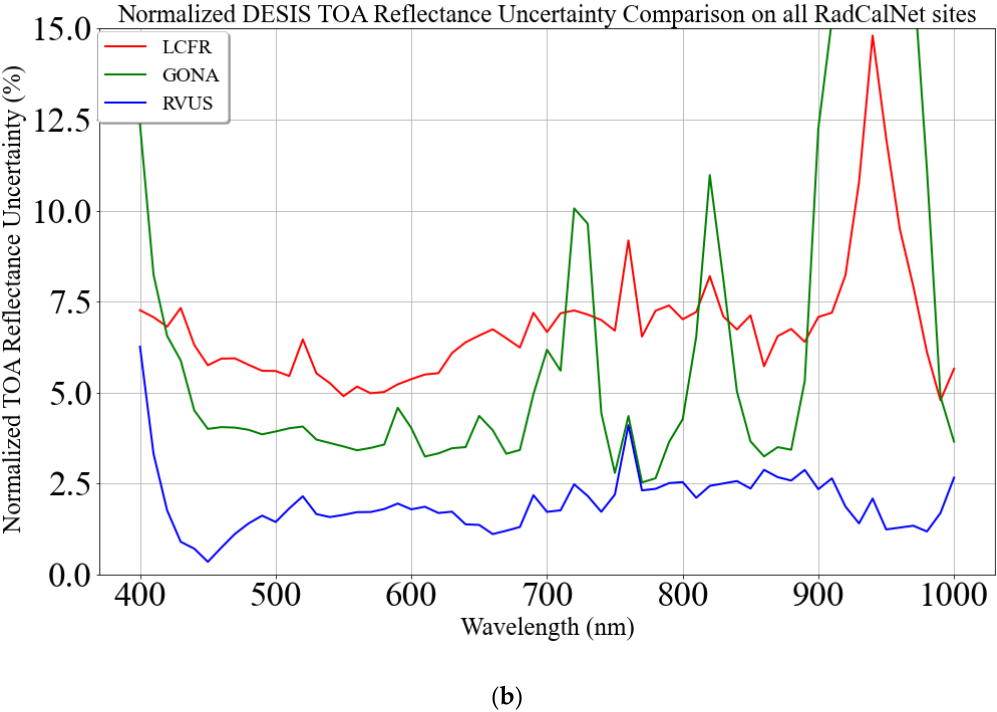
Figure 19. Mean of normalized DESIS TOA reflectance using different sites ( a ) and its corresponding uncertainty ( b ). The blue, green, and red data represent RVUS, GONA, and LCFR data,